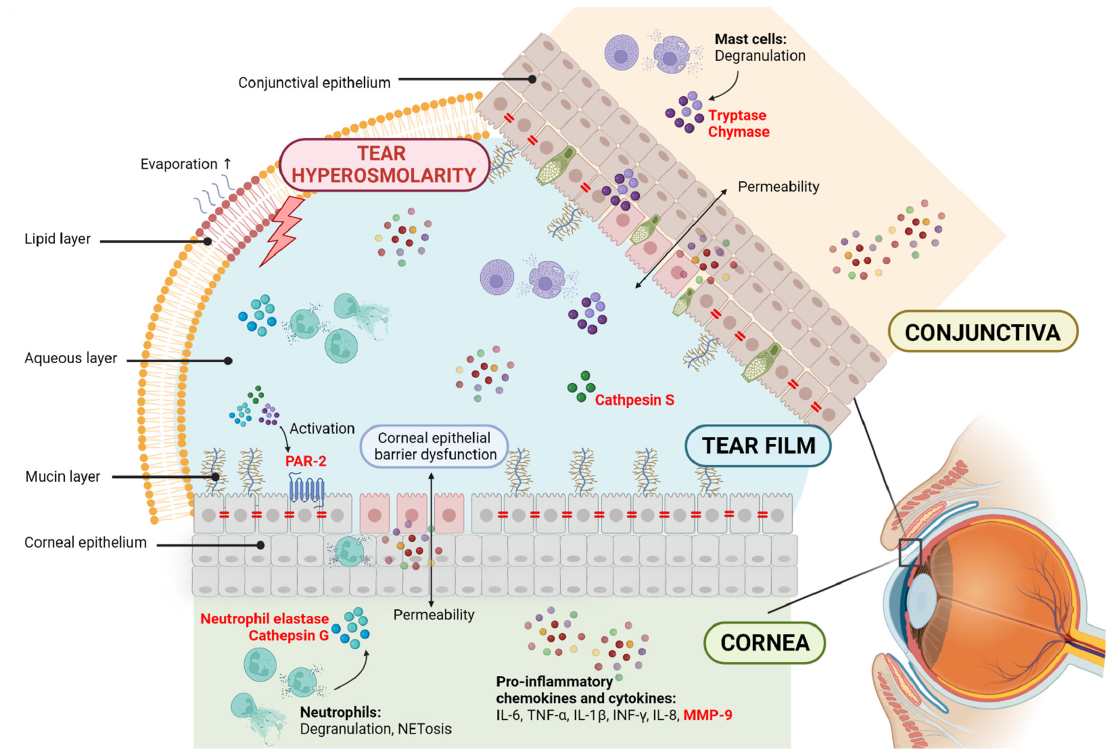
Figure 1. Potential contribution of proteases in dry eye disease (DED). The disruption of homeostasis of the tear film is accompanied by tear instability and hyperosmolarity and ocular surface in- flammation and damage. DED is related to corneal epithelial barrier dysfunction, allowing permeability and cell circulation to the tear film. This elevates the production of proinflammatory chemokines and cytokines, including the metalloprotease MMP-9. Neutrophils and mast cells are innate immune cells in the cornea and conjunctiva that, upon degranulation, release biological mediators to the environment, including serine proteases. Cathepsin S is a cysteine protease found in the tears of Sjögren syndrome patients. Proteases are known to promote the expression and activation of proin- flammatory cytokines and impact the degradation of extracellular matrix components and the loss of epithelial barrier function. Proteases are also known for activating protease-activated receptors (PARs) and starting intracellular signaling. PAR-2 is expressed in corneal epithelial cells. In red, the proteases and protease-activated receptors are